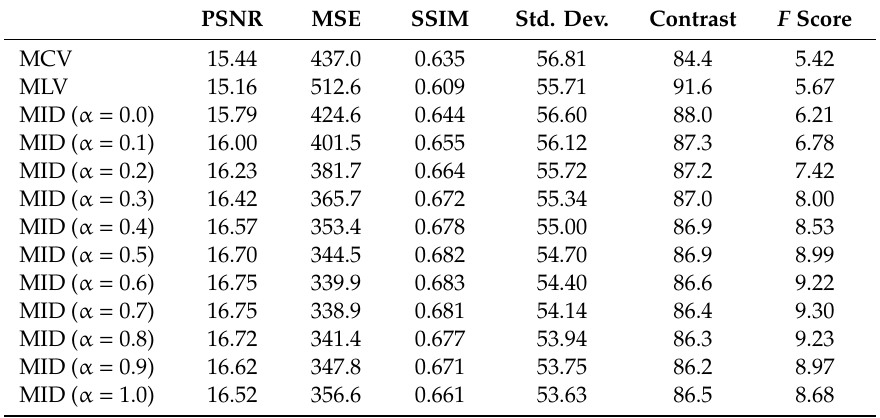
Table 3. Total average results of filtering experiments when the kernel size is set to 5. PSNR MSE SSIM Std. Dev. Contrast F Score MCV 15.44 437.0 0.635